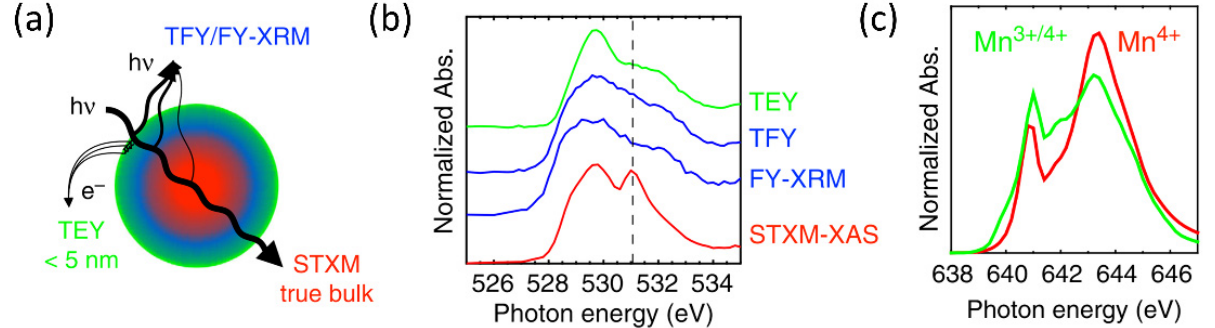
Figure 4. ( a ) Schematic comparing of XAS in various modes; ( b ) The oxygen K-edge XAS spectra collected in various modes; ( c ) The Mn L-edge XAS spectra detected by STXM. The chemical composition is Li 1.17 Ni 0.21 Co 0.08 Mn 0.54 O 2 . Reproduced with permission from Ref. [51] Copyright 2017, Nature Portfolio.